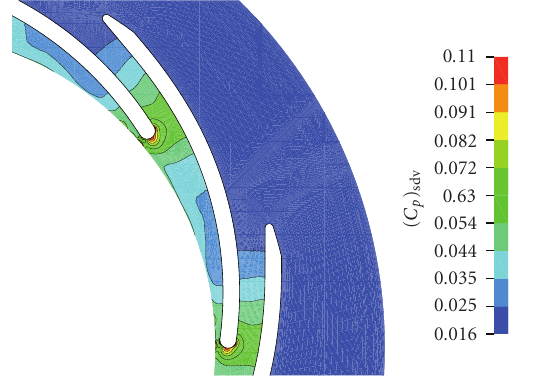
Figure 6: Pressure fluctuation in the di ff user at midspan Q des .